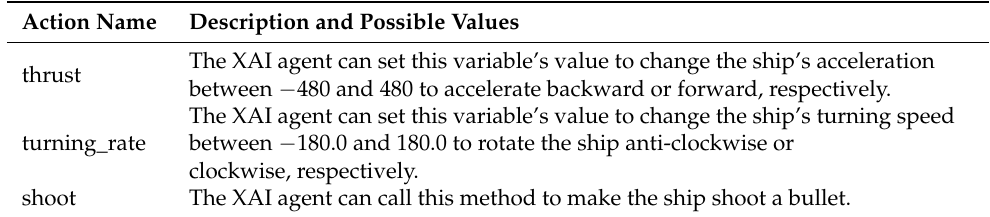
Table 3. Available actions XAI agent can perform to control the ship.